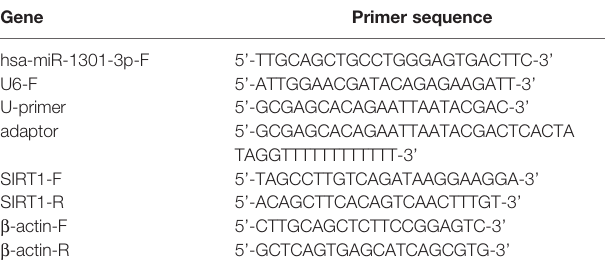
TABLE 1 | Sequences used in this